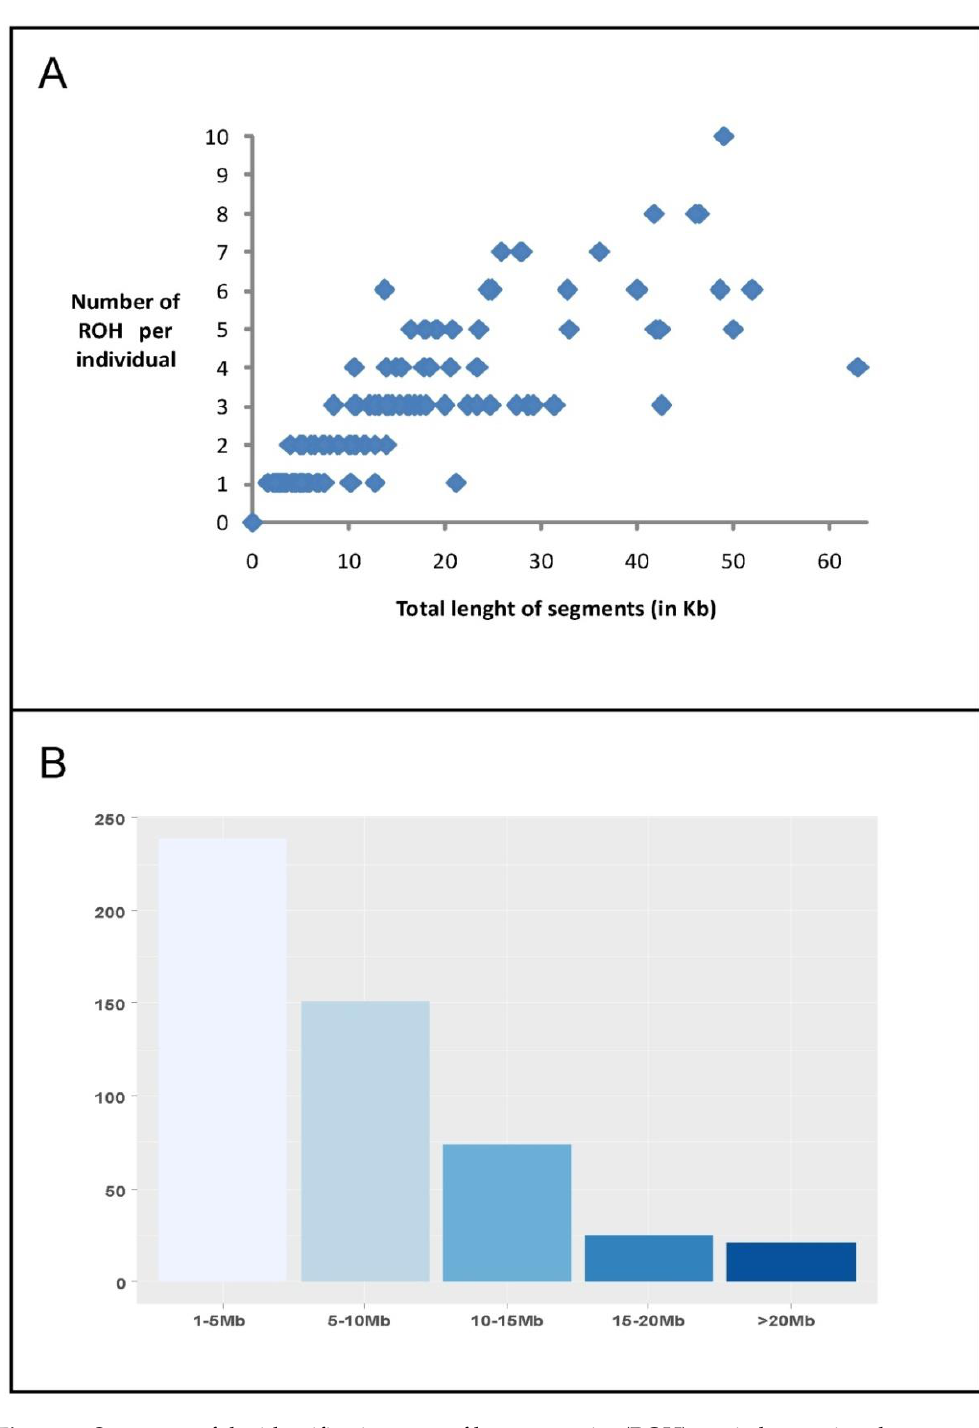
Figure 2. Summary of the identification runs of homozygosity (ROH) carried out using the program PLINK. ( A ) The ROH complement (total length and number) per individual in Djallonké sheep. ( B ) The frequency of ROH according to their length.